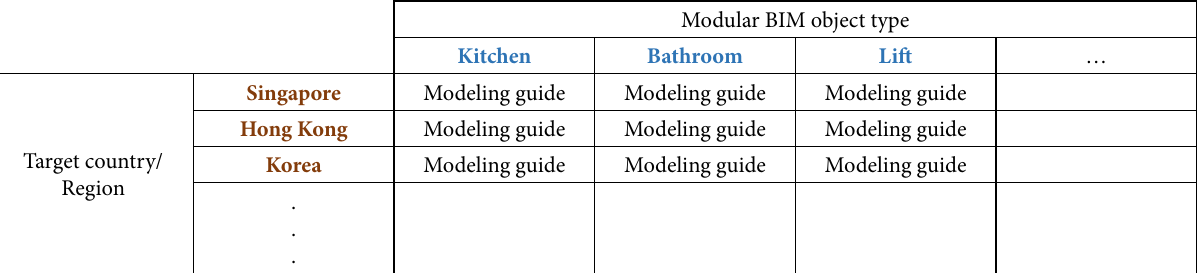
Table 2. Modular BIM object modeling guides for different products in different countries or